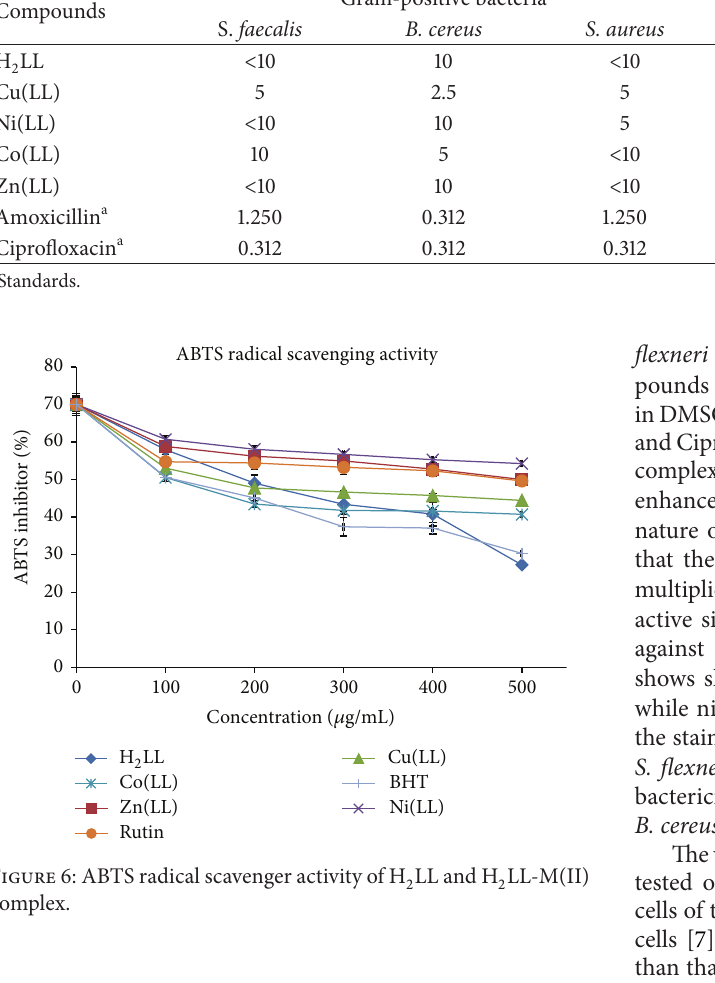
Table 5: ABTS radical scavenging activities (IC